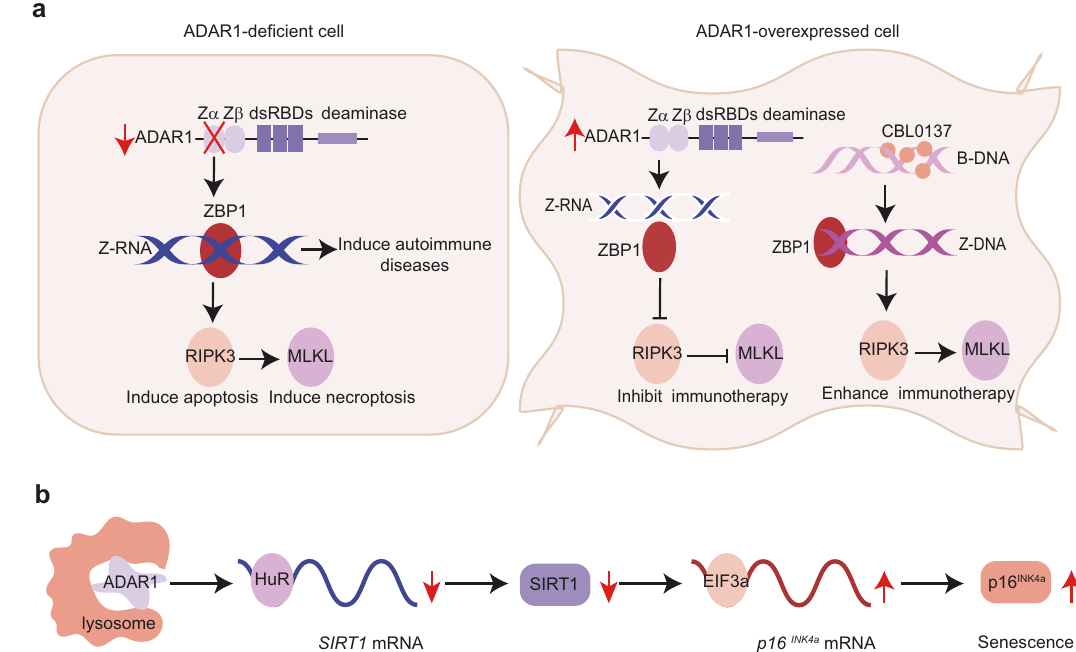
Fig. 1 ADAR1 regulates immune response and senescence through A-to-I RNA editing dependent and independent pathways, respectively. a Mutation of the ADAR1 Z α domain or ADAR1 depletion causes de fi ciency in A-to-I RNA editing, leading to the accumulation of Z-RNA. The accumulated Z-RNA subsequently activates ZBP1 to drive autoimmune diseases by inducing necroptosis or apoptosis in ADAR1- de fi cient cells. In contrast, ADAR1 tends to be overexpressed in cancer. The elevated expression of ADAR1 will reduce Z-RNA accumulation through A-to-I RNA editing, thereby inhibiting ZBP1 activation and ZBP1-mediated programmed necrosis of cells. Considering the similarity between Z-DNA and Z-RNA in structure, Zhang et al. screened a small molecule, CBL0137, that can transform a large amount of B-DNA into Z-DNA for activating ZBP1 to enhance immunotherapy. b In aging cells, ADAR1 is downregulated by the lysosomal-mediated autophagy pathway, which decreases the association between HuR and SIRT1 mRNA, leading to the signi fi cantly reduced stability of SIRT1 mRNA. The reduced expression of SIRT1 will further promote the association of EIF3a with p16 INK4a mRNA to accelerate its translation. This A-to-I independent pathway appears to be a mast regulator of cell senescence through modulating p16 INK4a